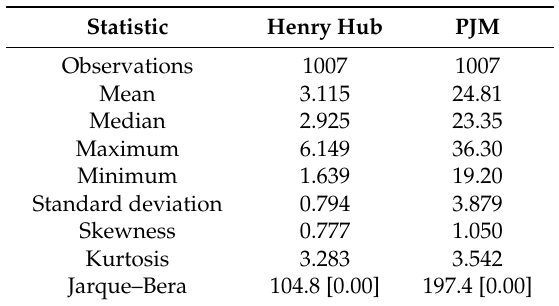
Table 1. Summary statistics.